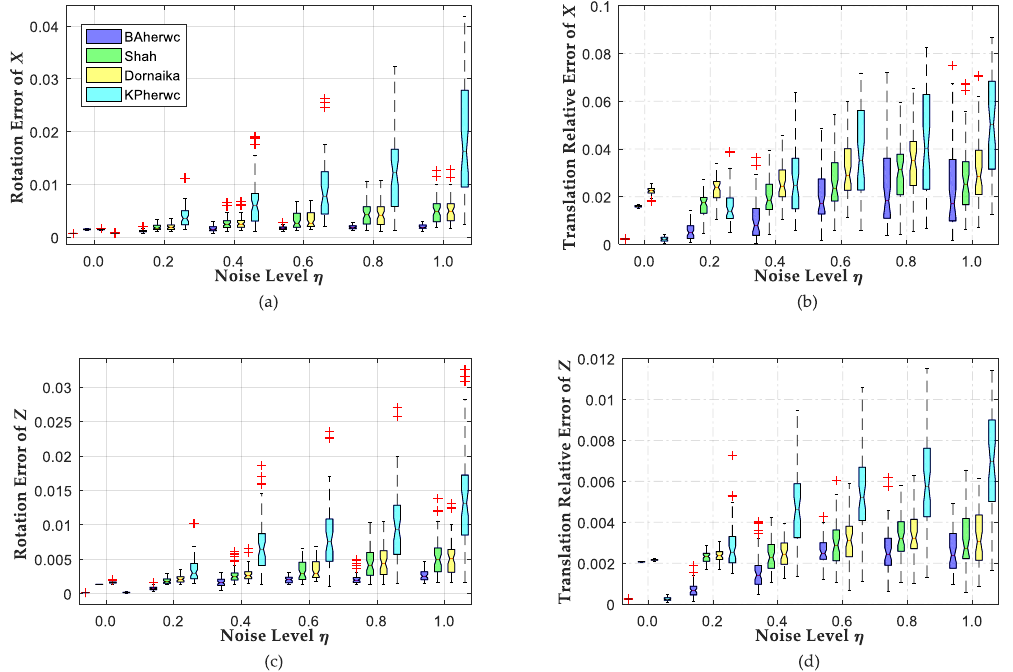
Figure 3. Error of estimated rotation and translation against different noise levels η : ( a , b ) The rotation and translation errors with regard to hand – eye transformation X ; ( c , d ) The rotation and translation errors with regard to robot – world transformation Z